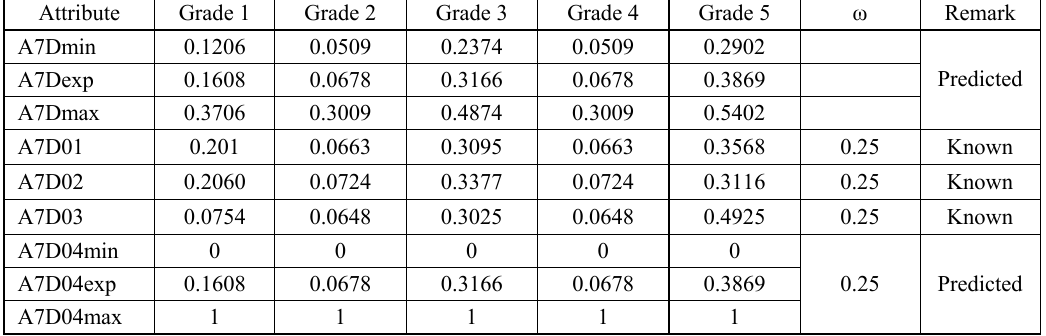
Table 10 Estimate value and estimation interval for the missing